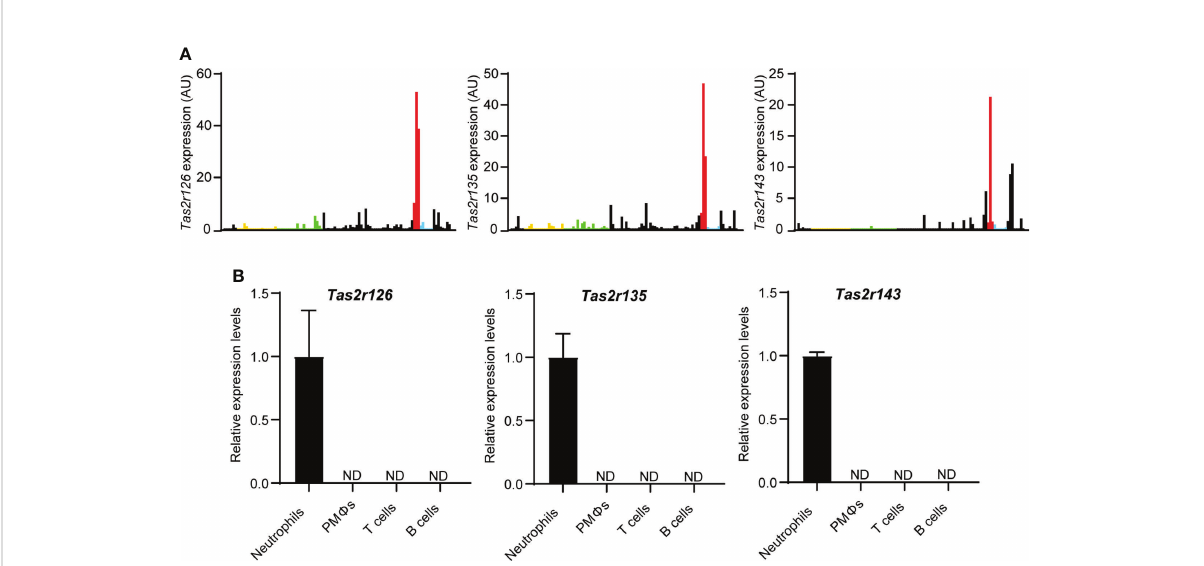
FIGURE 1 Neutrophils express Tas2r126 , Tas2r135 , and Tas2r143 . (A) Analysis of Tas2r expression in immune cells from the ImmGen RNA-seq dataset. The data shown is Tas2r126 , Tas2r135 , and Tas2r143 mRNA levels in immune cells. Yellow, green, red, and blue bars show Tas2r126 , Tas2r135 , or Tas2r143 mRNA expression in B cells, T cells, neutrophils, or macrophages. Black bars show the mRNA expression in immune cells other than B cells, T cells, neutrophils, and macrophages. (B) RT-qPCR analysis of Tas2r126 , Tas2r135 , and Tas2r143 mRNA levels in puri fi ed spleen-derived B220 + B cells or CD4 + /CD8 + T cells; F4/80 + /CD11b + peritoneal macrophages (PM F s); and bone marrow-derived CD11b + /Ly6G + neutrophils. Data are presented as the mean ±SD of triplicates from one experiment and are representative of three independent experiments. ND, not